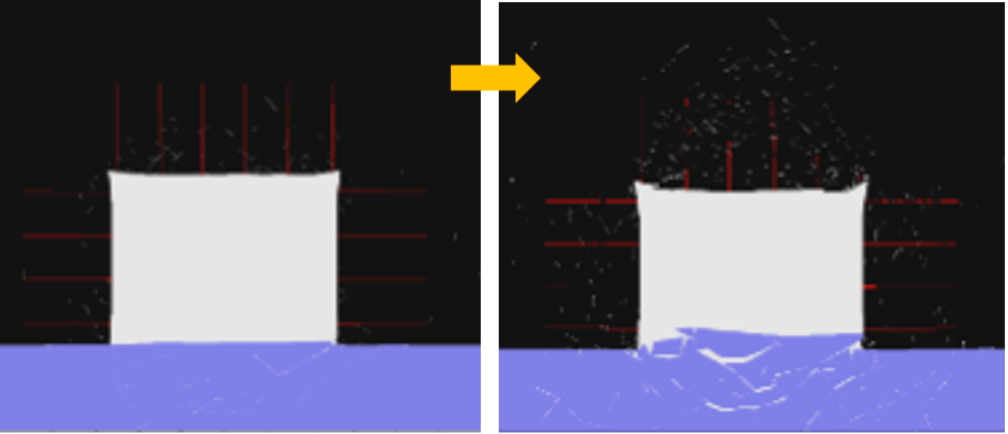
Figure 10. The evolution of discontinuous deformation failure in the surrounding rock.